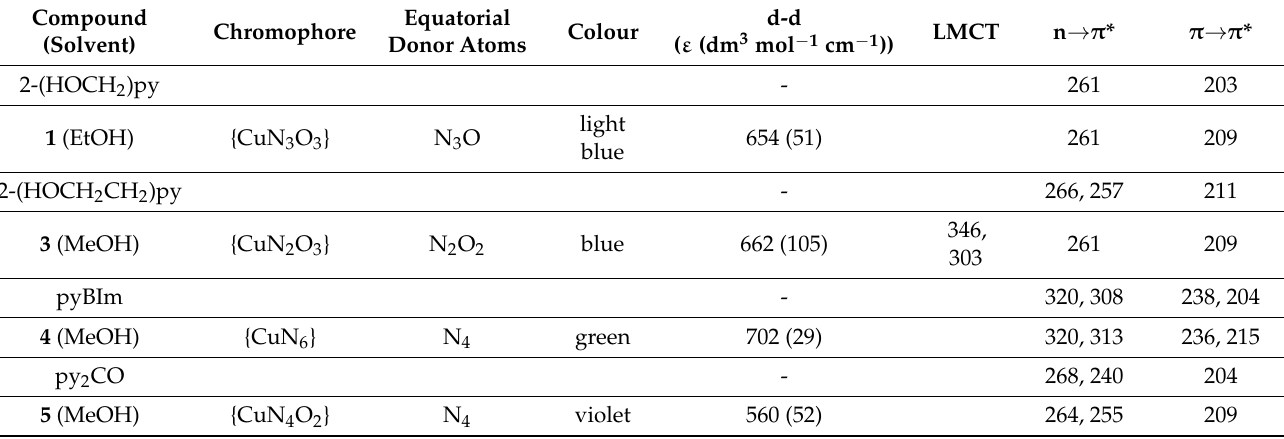
Figure 7. UV-Vis spectra with inserted of d-d transition of ( a ) 2-(HOCH 2 )py (red line) and complex 1 (pink line) in ethanol, ( b ) 2-(HOCH 2 CH 2 )py (red line) and complex 3 (blue line), ( c ) pyBIm (red line) and complex 4 (celadon line), ( d ) py 2 CO (red line) and complex 5 (violet line) in methanol. Table 4. Electronic absorption spectral data of